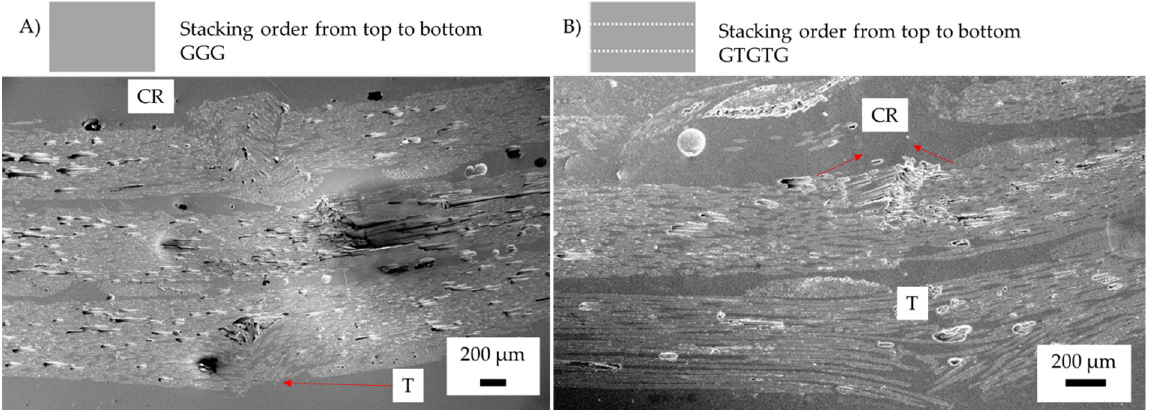
Figure 16. Post failure micrographs of control samples after three-point bending and toughened samples with Xantu.Layr ® : ( A ) control glass fibre (GF), ( B ) glass fibre toughened (GFT), Annotation: CR (fibre crushing) and T (tension rupturing). Red lines indicate fibre failure.